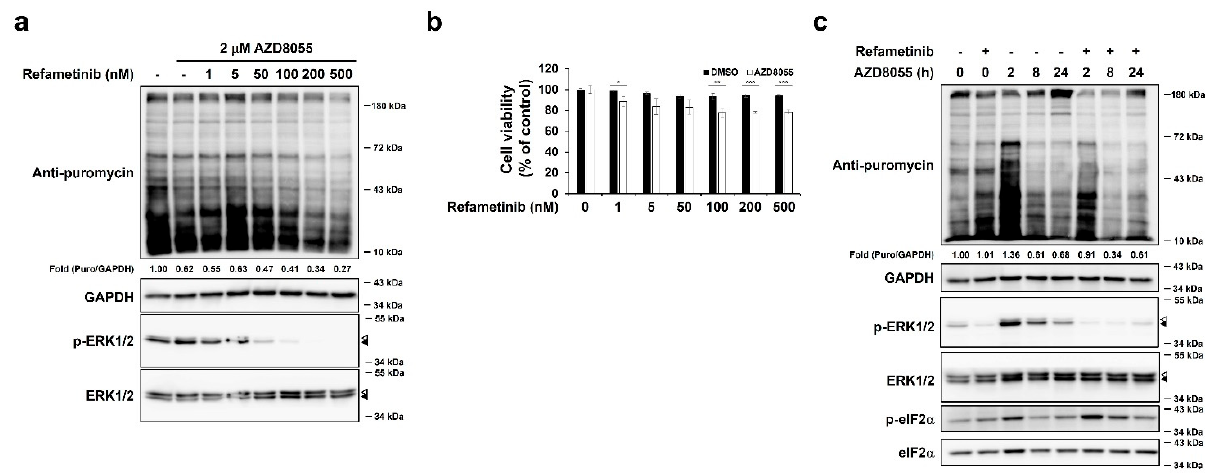
Figure 4. Inhibition of ERK1/2 enhances the efficacy of AZD8055–mediated inhibition of protein synthesis. ( a ) HepG2 cells pre–treated with various concentrations of the MEK1/2 inhibitor refametinib for 1 h were treated with 2 μ M AZD8055 for 8 h by adding an AZD8055 solution, and the relative rate of protein synthesis was determined by immunoblotting using specific antibodies for puromycin, ERK1/2, p–ERK1/2, and GAPDH. ( b ) HepG2 cells were cotreated with various concentrations of refametinib and 2 μ M AZD8055 for 8 h, and cell viability were measured using MTT assay. The data obtained from three independent experiments were presented as means ± S.D. Statistically significant differences were calculated using Student’s t ‐ test and indicated as * p < 0.05, ** p < 0.01, and *** p < 0.001. ( c ) HepG2 cells pre–treated with or without 100 nM refametinib for 1 h were treated with 2 μ M AZD8055 for indicated periods. Cell were labeled with puromycin for 10 min and immunoblot analysis was performed using specific antibodies for puromycin, GAPDH, ERK1/2, p–ERK1/2, eIF2 α , and p–eIF2 α . The relative levels of puromycin were normalized using GAPDH. Fold changes were used to compare the relative translation levels between AZD8055 treated–HepG2 cells with or without refametinib treatment. Open arrowheads and closed arrowheads indicate ERK1 and ERK2,